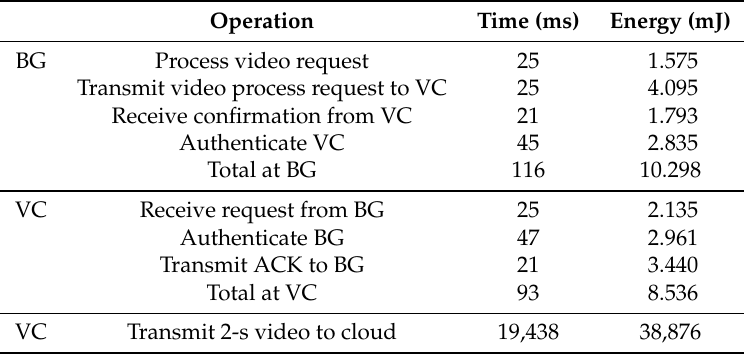
Table 4. Energy consumption at the BG and